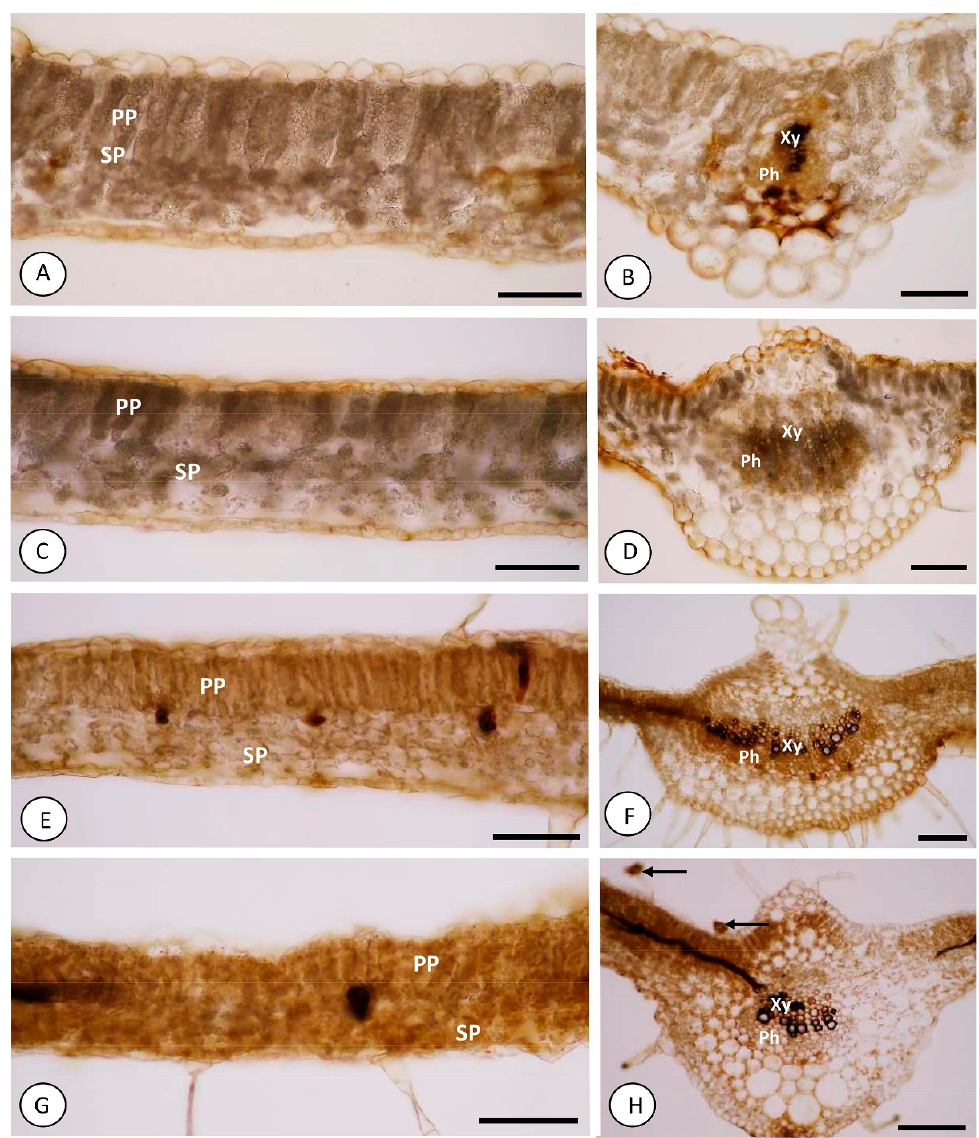
Figure 3. Photomicrographs of the median cross sections of the leaf blade of Solanum lycopersicum “cv. Micro-Tom” stained with 3,3 ′ -diaminobenzidine (DAB) at 0.5 h after mechanical damage. ( A , B ). absence of Ca 2+ and without mechanical damage. ( C , D ). absence of Ca 2+ and with mechanical damage. ( E , F ). presence of 2 mM Ca 2+ and without mechanical damage. ( G , H ). presence of 2 mM Ca 2+ and with mechanical damage. ( A , C , E , G ). Mesophyll region. ( B , D , F , H ). Midrib. PP—Palisade parenchyma; SP—Spongy parenchyma; Xy—Xylem; Ph—Phloem; ↑ (arrow)—Glandular trichome. Bars: (( A , B , C , E , G ) = 100 μ m); (( D , F , H ) = 150 μ m).